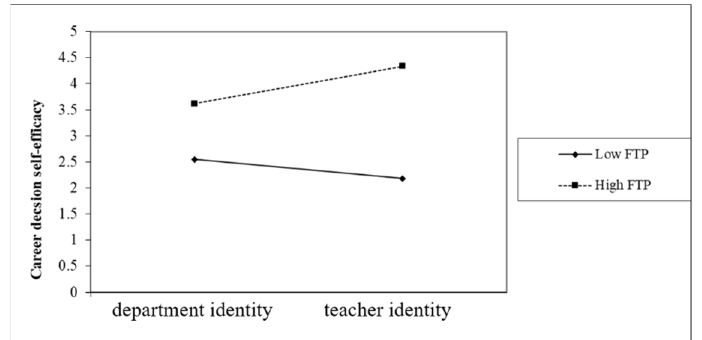
Figure 4. The moderation effect of profession identity on the relationship between FTP and CDSE.